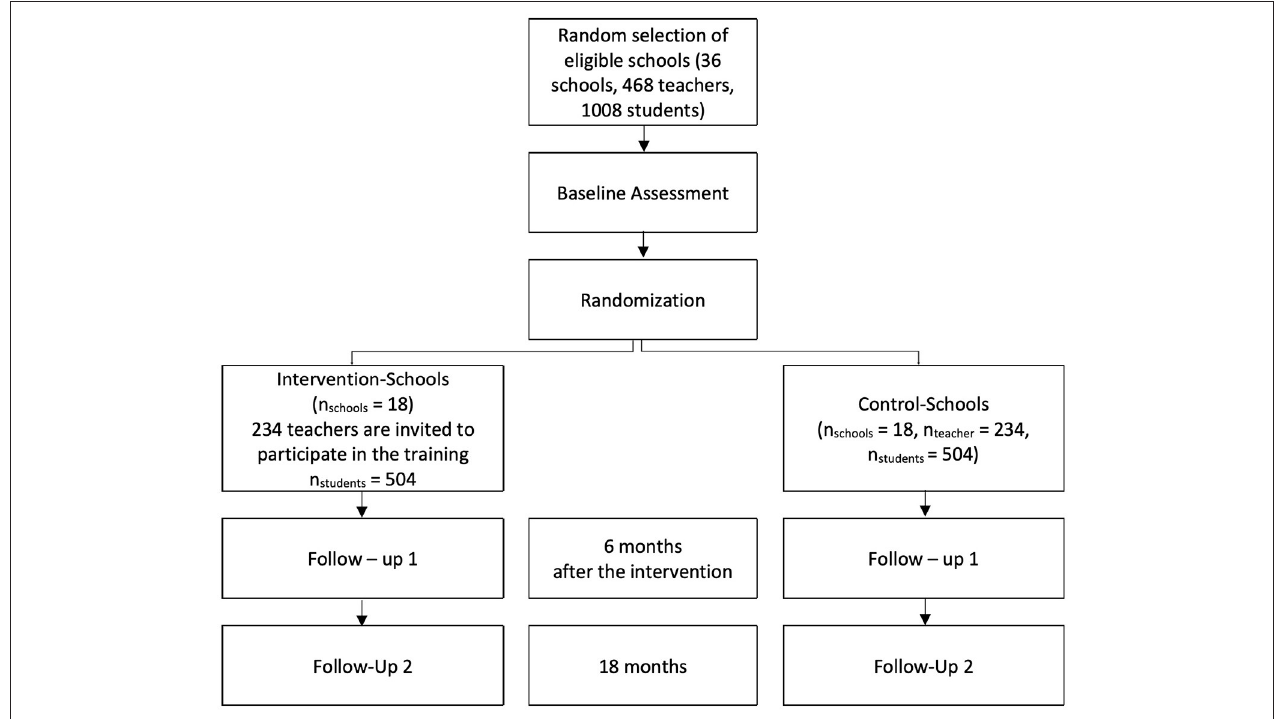
FIGURE 1 | Flow chart of the study